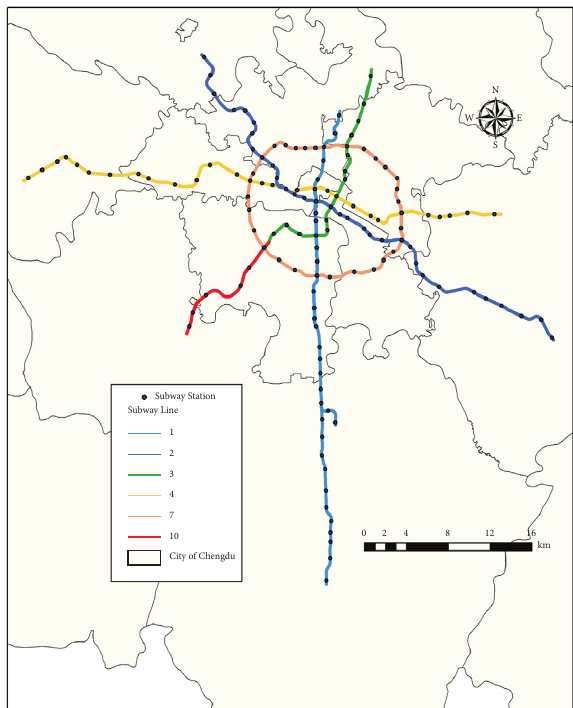
Figure 1: Chengdu subway